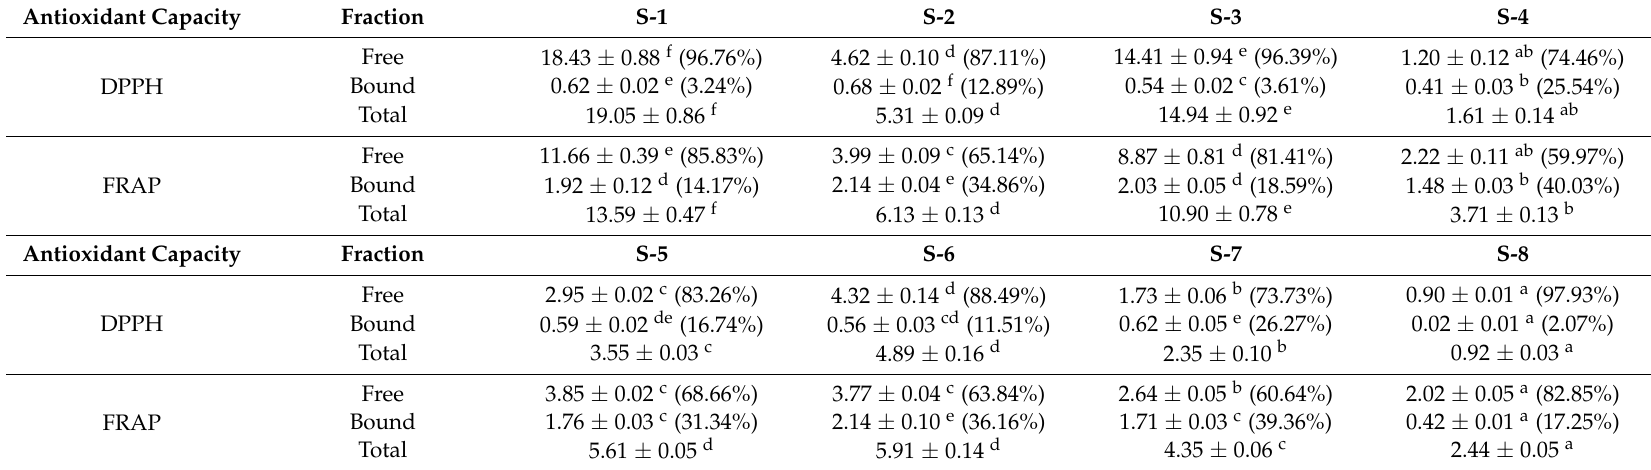
Table 5. Antioxidant capacity (mg VcE 1 /g grain, DW 2 ) 3 of free and bound phenolic extract measured by 2,2-diphenyl-1-picrylhydrazyl radicals (DPPH) and ferric reducing ability of plasma (FRAP)